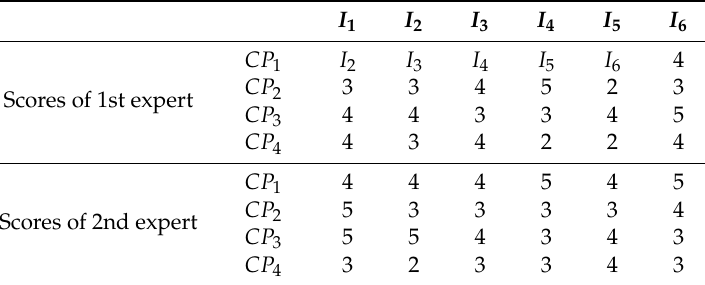
Table A9. Scores of the status level of the criteria layer